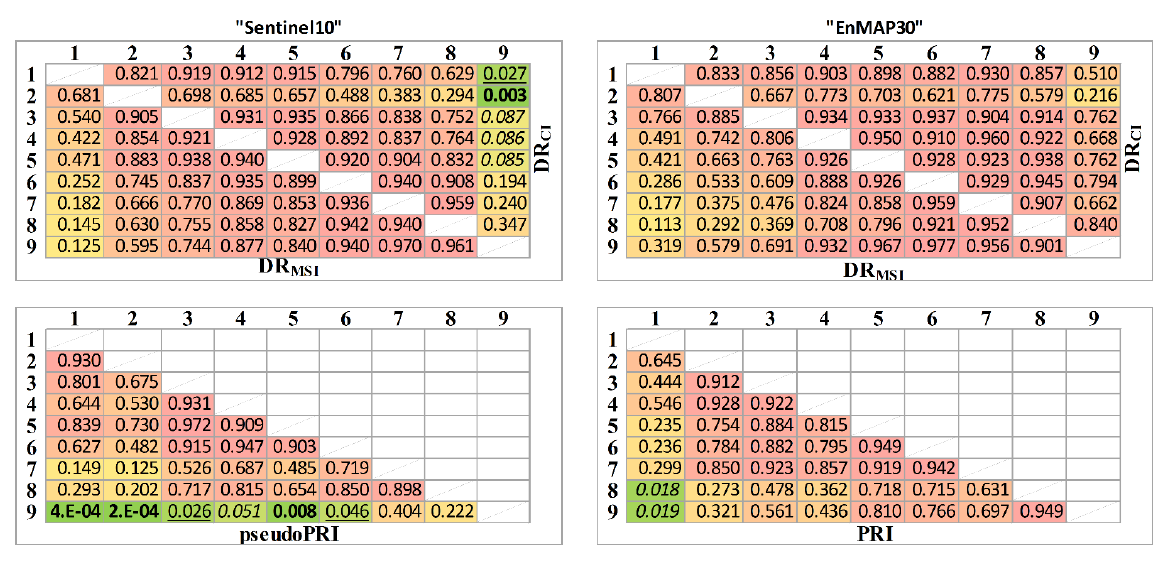
Figure 12. P -values for “Sentinel10” DR MSI , DR CI , and “pseudoPRI”, ( left ) and “EnMAP30” DR MSI , DR CI , and PRI ( right ). Color scheme and character styles